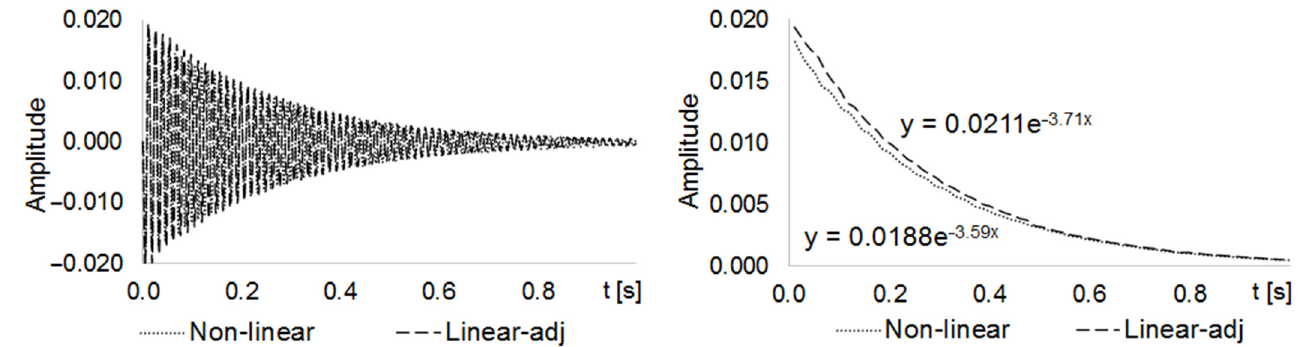
Figure 9. Nonlinear and linear adjusted z-dir displacement ( left ) and decaying rate ( right ) curves. Comparing the decay rate of the non-adjusted ( σ lin = − 3.233) and adjusted ( σ adj = −